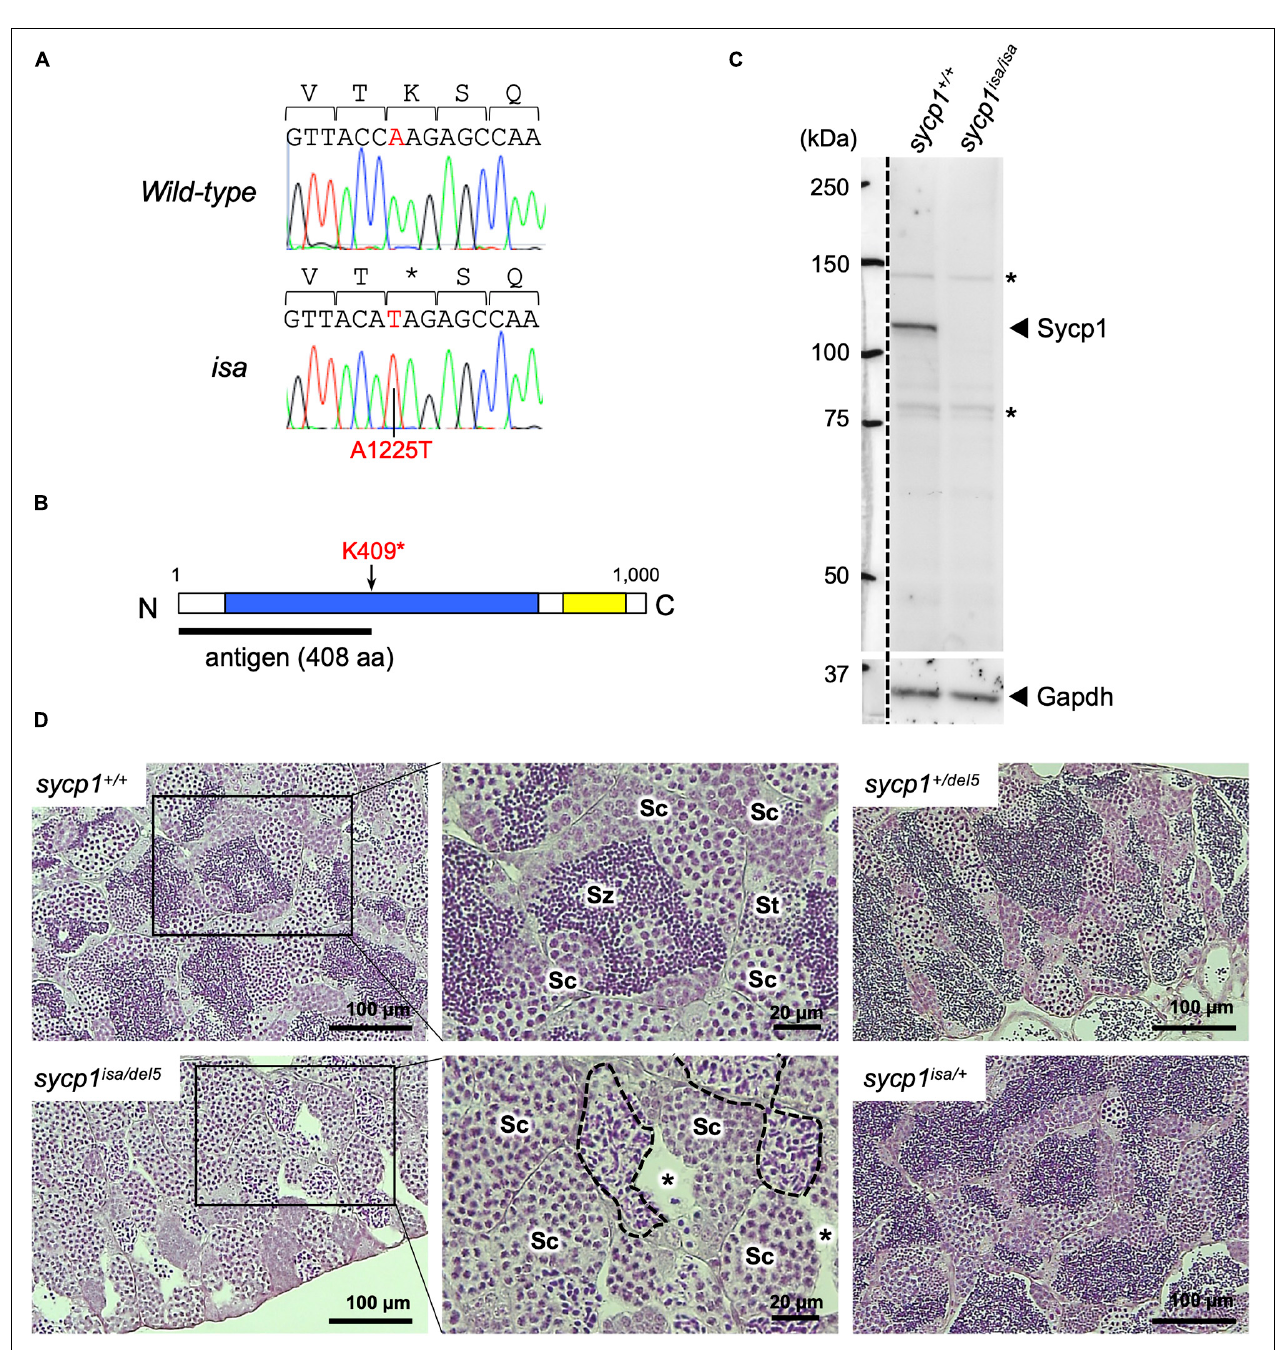
FIGURE 1 | A premature stop mutation of the sycp1 gene in the isa mutant line. (A) Genomic sequences of a part of exon 15 in the sycp1 gene. DNA sequences and peaks obtained from a wild-type and an isa mutant fish are shown with corresponding amino acids (above in 1-letter abbreviations). Positions of the isa mutation (base 1225 of the sycp1 coding sequence) are shown in red letters. (B) A schematic presentation of the Sycp1 protein sequence. The isa mutation site is indicated with an arrow. The antigen region (amino acids 1 to 408) of the Sycp1 antibody used in this study is shown below as a black bar. N: N-terminus, C: C-terminus. Numbers indicate corresponding amino acid positions. (C) Western blotting of the Sycp1 protein. Testis protein extracts of wild-type ( sycp1 + / + ) and isa homozygote mutant ( sycp1 isa / isa ) adult fish were blotted with anti-Sycp1 antibody and anti-Gapdh antibody as an internal control. The left side of the broken line is a part labeled with a molecular ladder on the same membrane. The predicted molecular sizes of full-length Sycp1 and Gapdh proteins are 116 kDa and 35.8 kDa, respectively. Non-specific bands were marked with asterisks (*). (D) HE-stained sections of sycp1 + / + , sycp1 isa / del 5 , sycp1 isa / + and sycp1 del 5 / + testes. All samples were prepared from siblings at 4 mpf (months post fertilization). Representative results of 3 individual fish are shown for each genotype. Magnified images are shown for sycp1 + / + and sycp1 isa / del 5 sections. Sc: spermatocytes, St: spermatids, Sz: spermatozoa. In the sycp1 isa / del 5 section, lumens with no spermatozoa (asterisks) and spermatocytes with irregular nuclei (inside broken lines) were